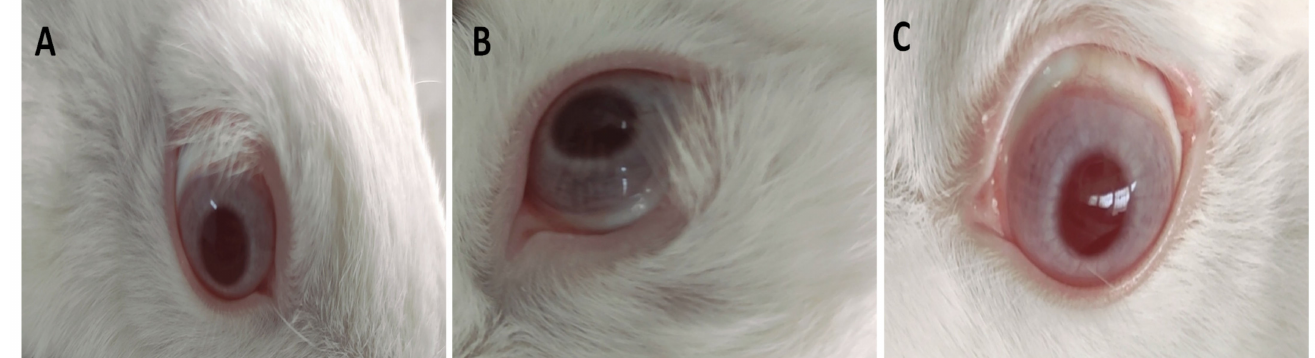
Figure 4. Representative photos of the eye irritation test for one representative rabbit for ( A ) Group I; untreated group, act as a control, ( B ) Group II; PBS (10 mM, pH 7.4) treated group, and ( C ) Group III; rhamnolipids nano-micelles solution (0.625 mg/mL) dispersed in PBS (10 mM, pH 7.4) treated